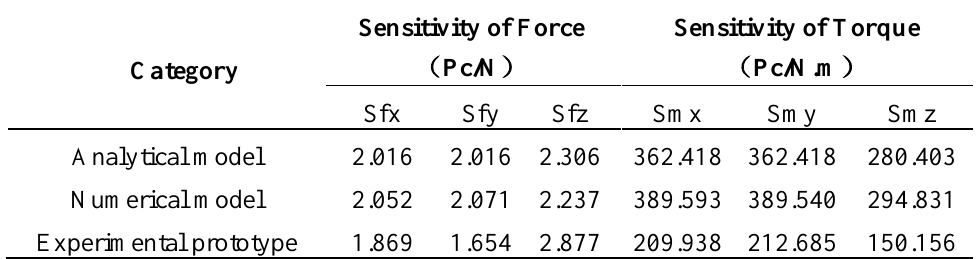
Table 2. Piezoelectric six-axis force/torque sensor